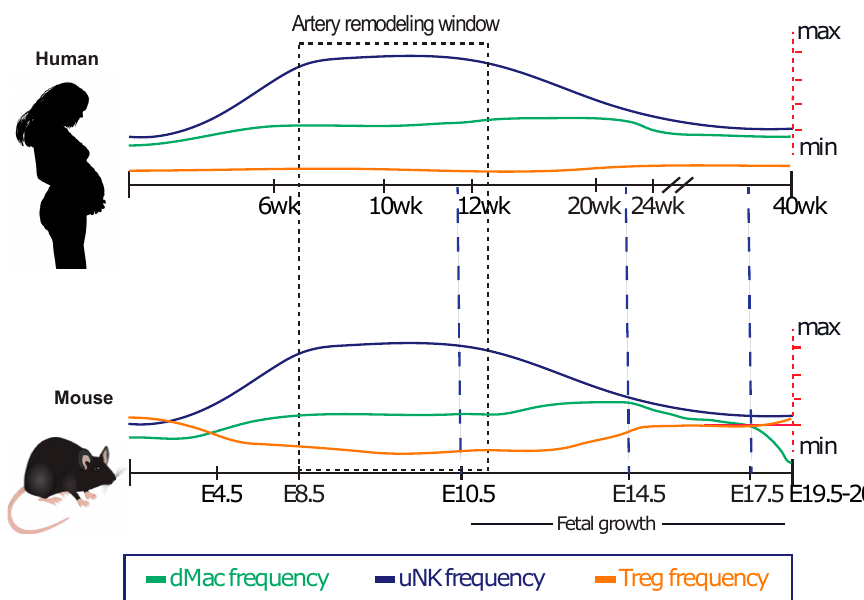
Figure 1. Timeline of human and mouse pregnancies with relative abundance of major decidual leukocytes. Important hallmarks during pregnancy are shown as well as the abundance of decidual M φ (green), uNKs (blue), regulatory T cells (Tregs) (orange), and total CD3 + T cells (purple) [23–25]. Y-axis represents percent of total leukocytes in the decidua. wk, week; E, embryonic day.